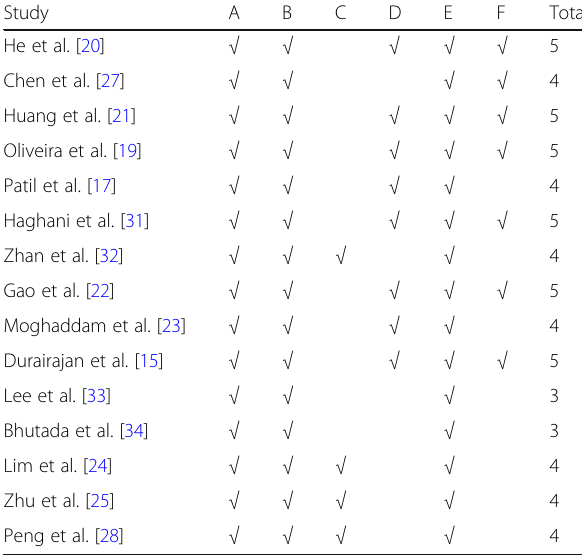
Table 2 Methodological quality of included studies